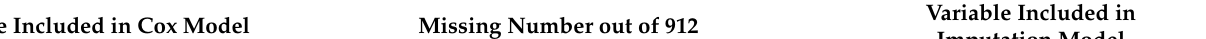
Table A2. Imputation Model 2 and 3: Used for Cox Proportional Hazards Presented in Table